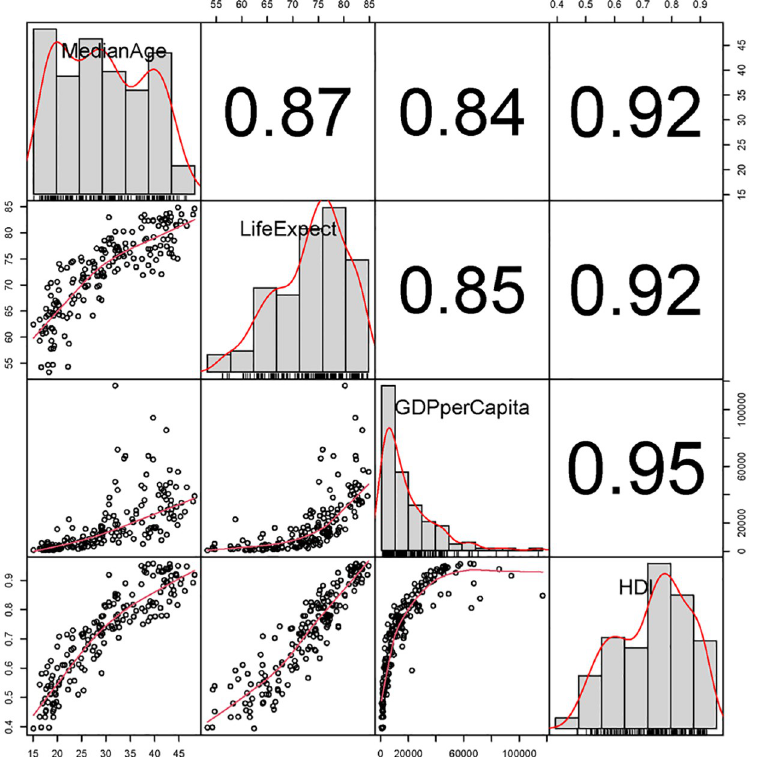
Fig 3. Distribution of studied continuous variables and their correlation with each other. Values are Spearman’s ρ . The median age (MedianAge), life expectancy at birth (LifeExpect), and the gross domestic product per capita (GDPperCapita), all had a significant (p < 0.001) high correlation with the human development index (HDI).